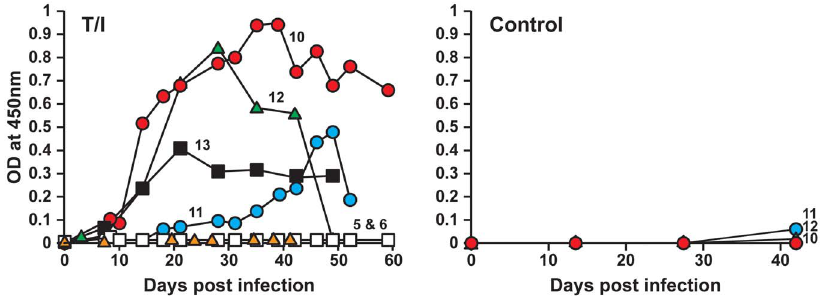
Figure 3. Antibody response of deer receiving infection by tick transmission. T/I refers to the animals receiving infection via tick bite and the Ehrlichia antigens used for the ELISA analysis are obtained from ISE6 cultures. Deer # s 5 and 6 are uninfected controls and deer # s 10–13 represent animals receiving infection by tick transmission. Control panel on the right refers to the ELISA analysis performed on sera from animals using the uninfected ISE6 host cell antigens.